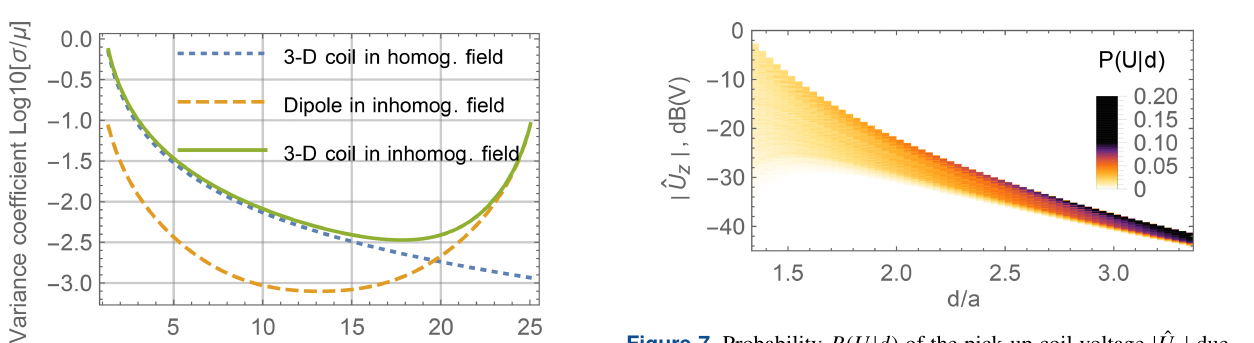
Figure 7. Probability P ( U | d ) of the pick-up coil voltage | ˆ U z | due to a 3-D coil in an inhomogeneous primary